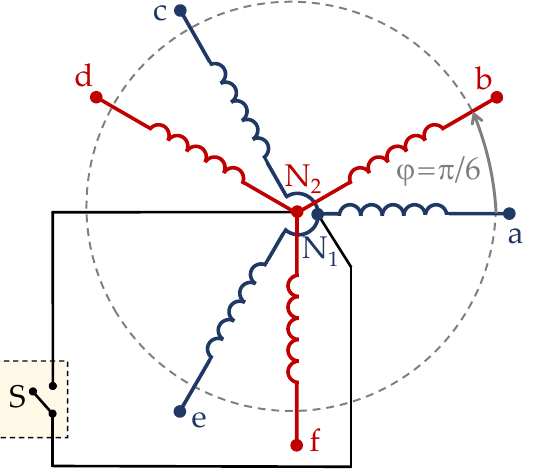
Figure 10. Stator scheme of a six-phase machine with asymmetrical WSA and a bidirectional switch S between the neutral points N 1 and N 2 of the two three-phase winding sets [24].